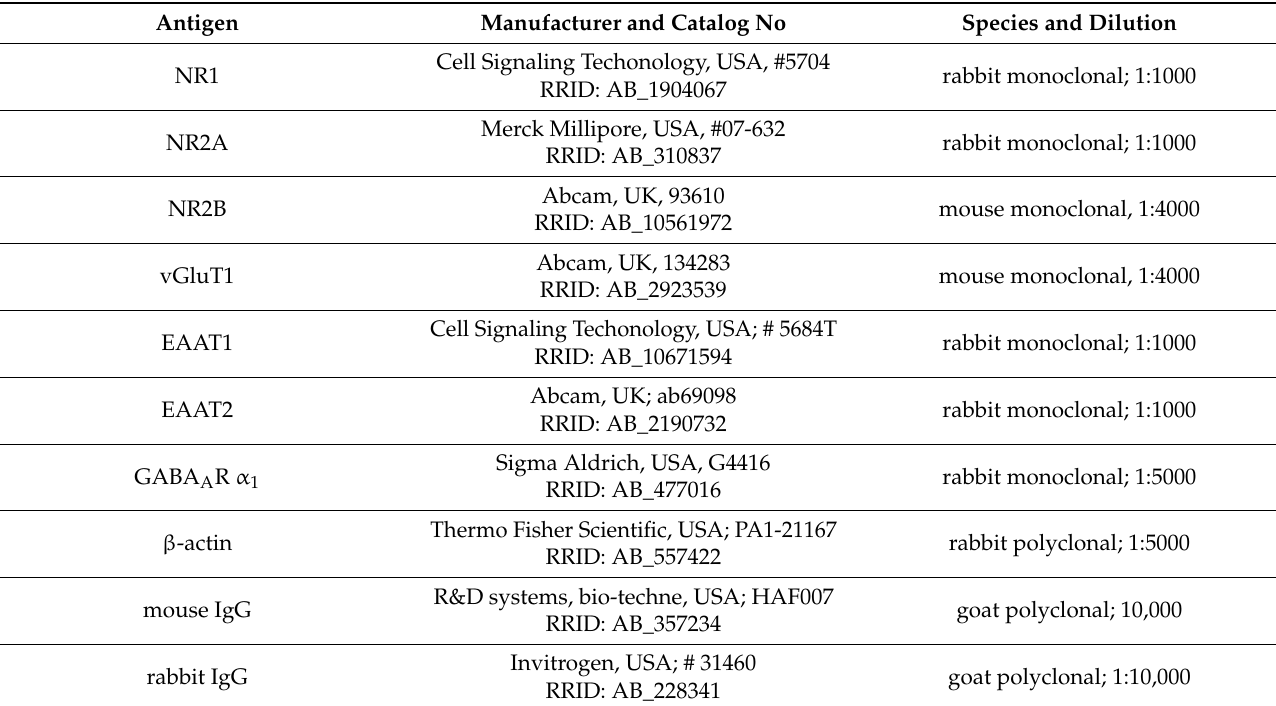
Table 1. List of primary and secondary antibodies used in Western blot